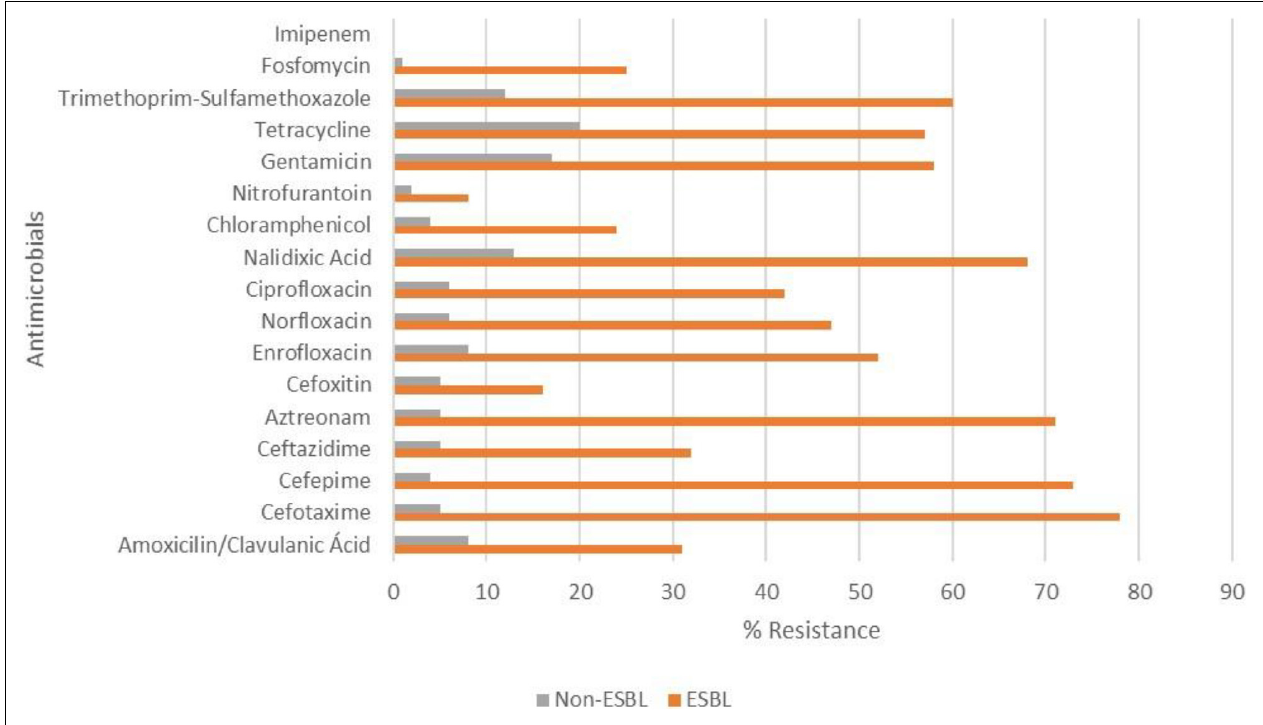
FIGURE 2 | Resistance of ESBL-producing and non-ESBL-producing E. coli strains isolated from poultry farms in southern Brazil. There were significant differences between ESBL-producing and non-producing strains ( p < 0.05), except for cefoxitin, nitrofurantoin and imipenem (all isolates were sensitive).